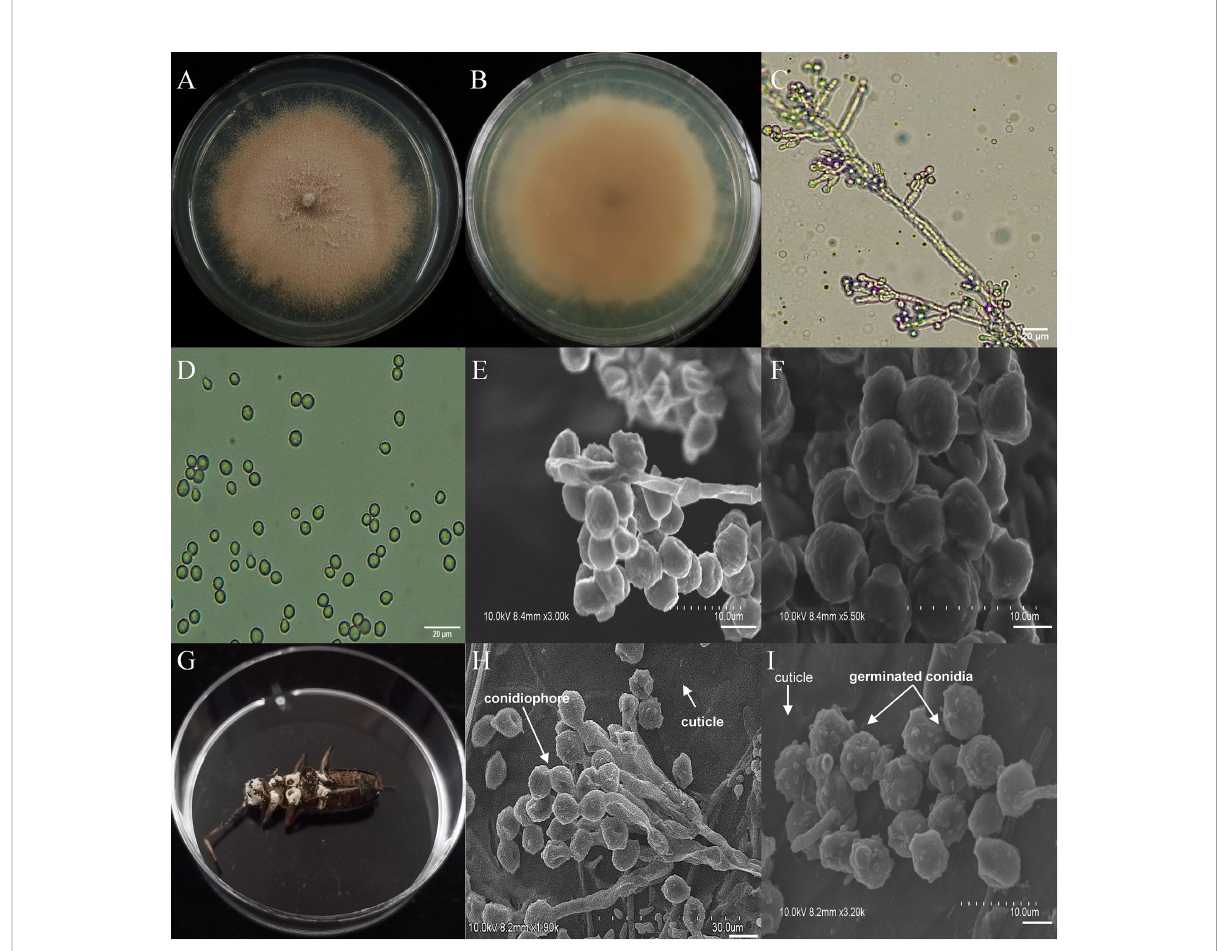
FIGURE 6 Morphology of S . albo fl avescens and M . alternatus cadaver infected by S . albo fl avescens under optical microscope and SEM. (A) Colonial morphology cultured on PDA. (B) Reverse of colony on PDA. (C) Hyphae and conidiophores (OM). (D) Conidia (OM). (E) Conidiophores (SEM). (F) Conidia (SEM). (G) M . alternatus cadaver surrounded by mycelia. (H) Conidiophores grown from M . alternatus cuticle (SEM). (I) Conidia on M . alternatus cuticle surface